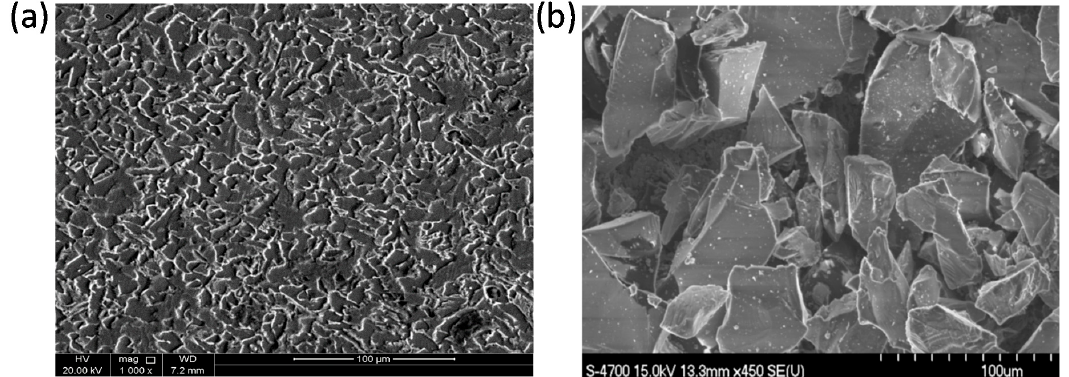
Figure 3. Micrographs of ( a ) API X100 steel and ( b ) alumina particles.